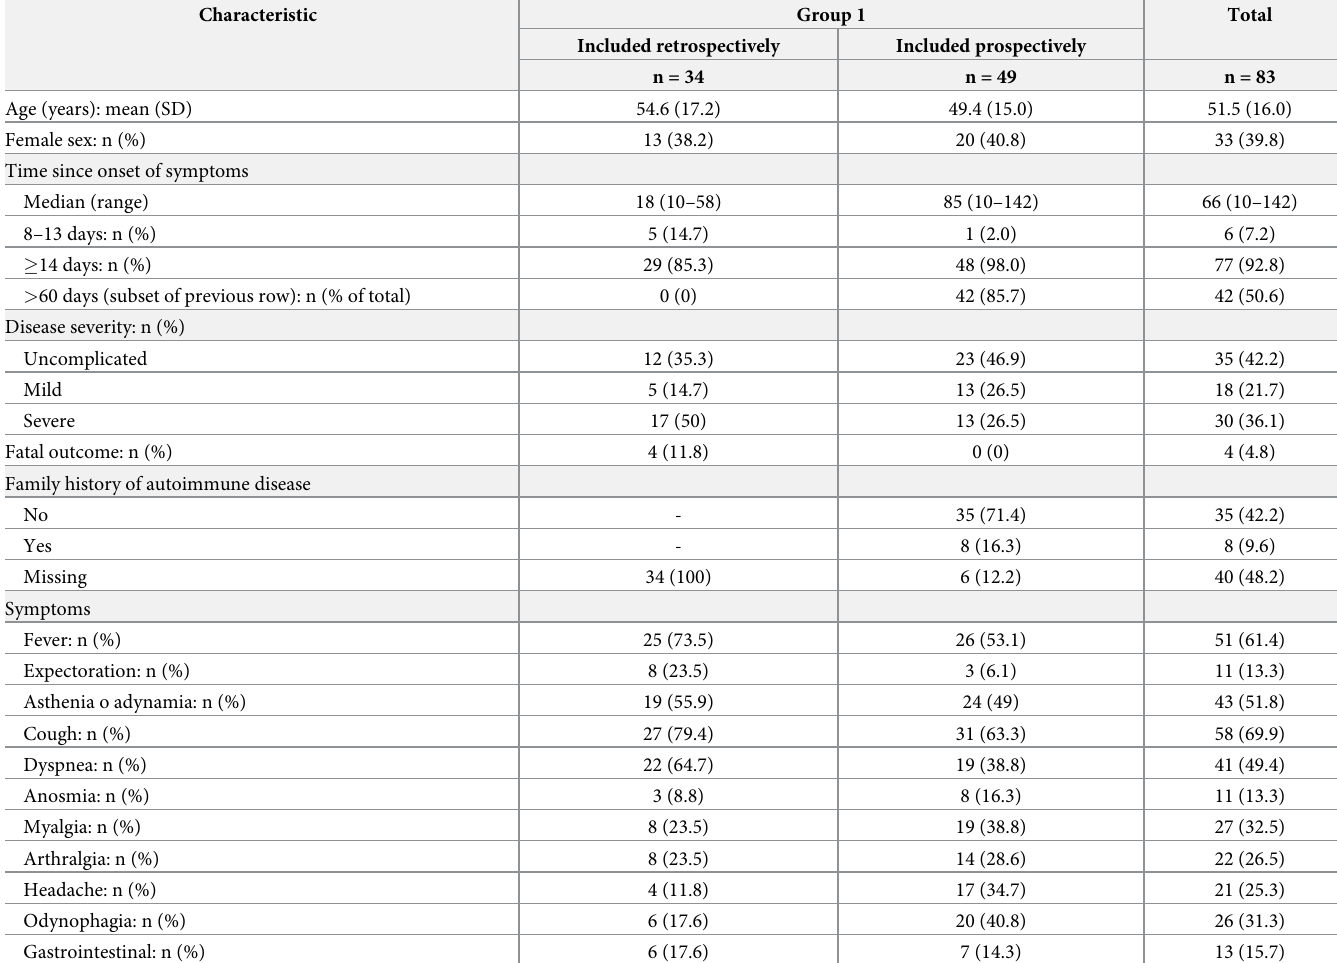
Table 1. Clinical and demographic characteristics of the study population. Characteristic